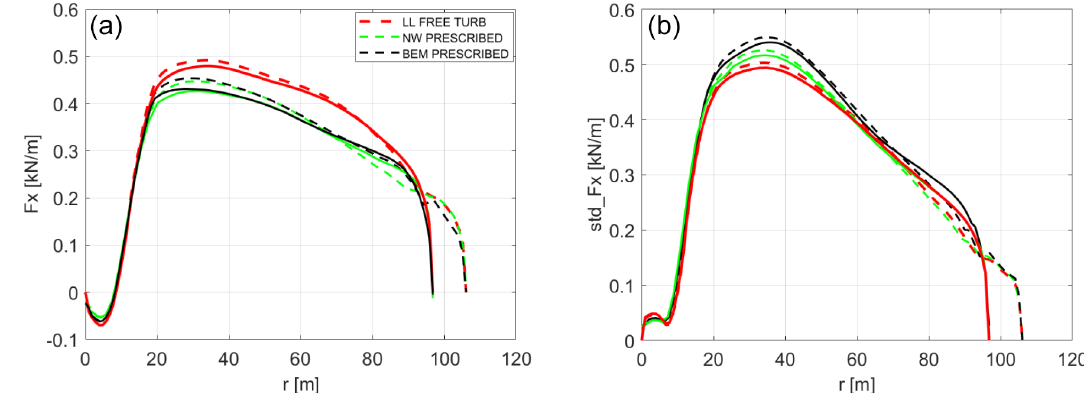
Figure 19. In-plane force (a) mean distribution and (b) standard deviation. Solid lines represent the baseline blade, while dashed lines represent the optimized tip design.